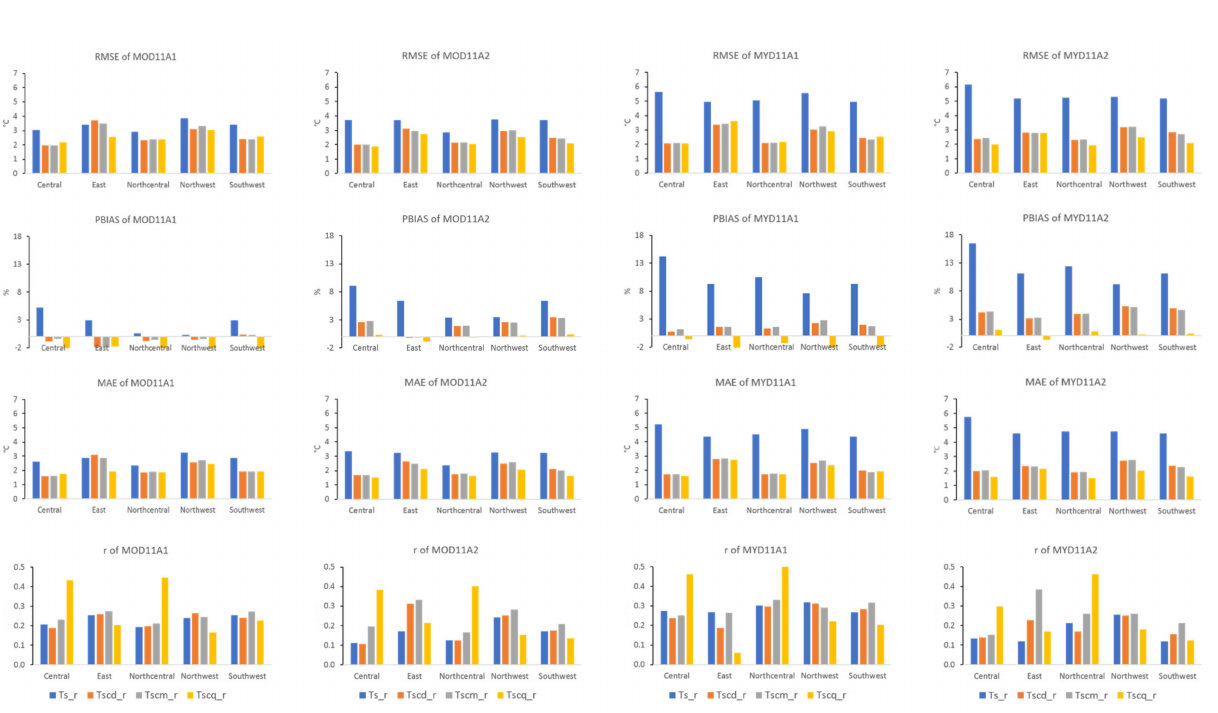
Figure 10. Comparison of evaluation metrics score between T s_r , T scd_r , T scm_r , and T scq_r against T a_r